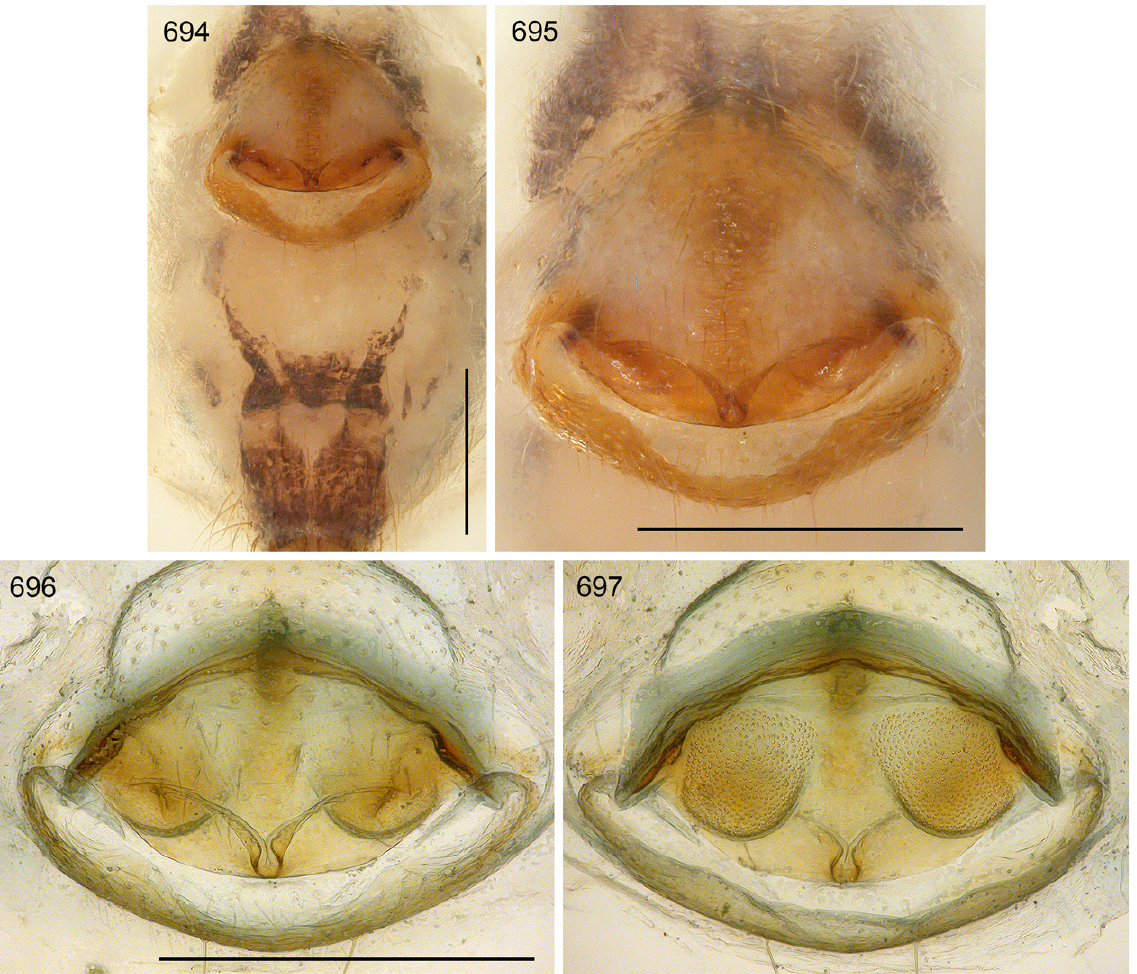
Figs 694–697. Crossopriza malegaon sp. nov.; female from India, 17 mi NE of Malegaon (CAS). 694–695 . Abdomen and epigynum, ventral views. 696–697 . Female internal genitalia, ventral and dorsal views. Scale bars = 0.5